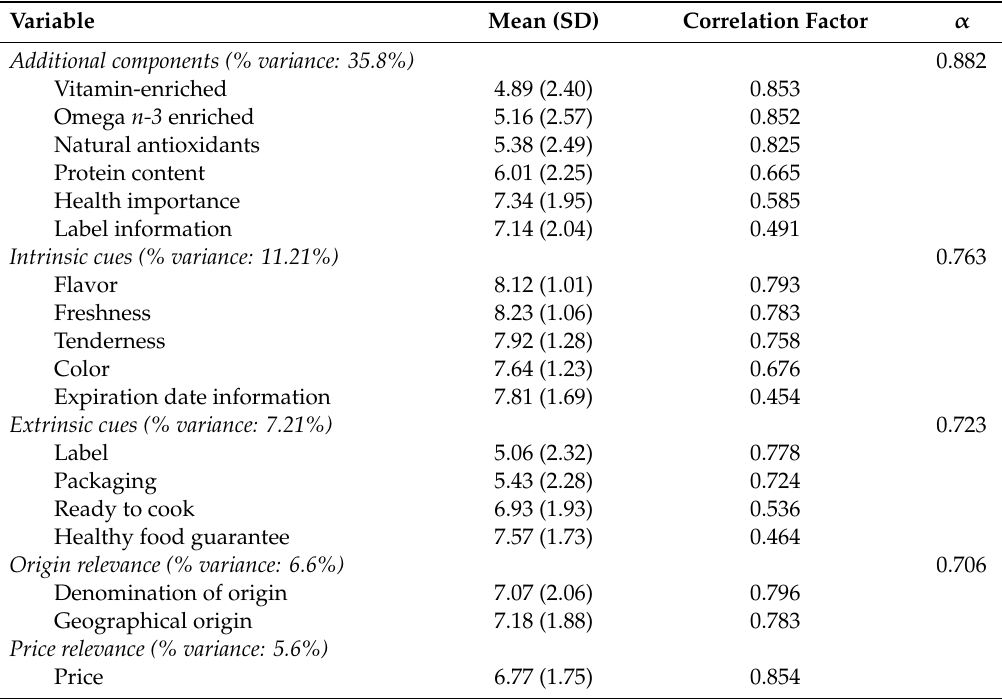
Table A1. Factor analysis of quality cues relevant to the purchase of beef.